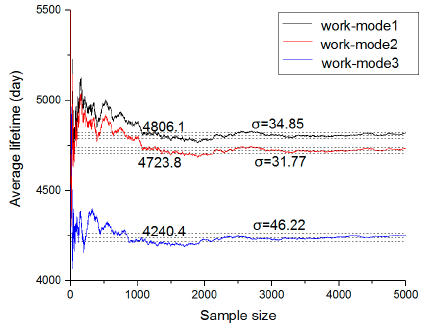
Figure 25. Life prediction of the FS with Configuration 2 in different work modes.